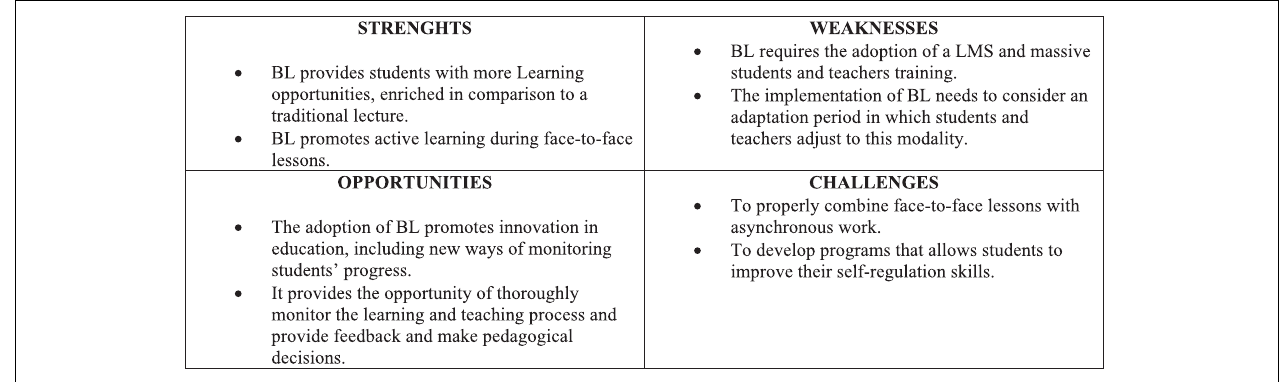
FIGURE 2 | SWOC Analysis of Blended Learning as possible post-pandemic COVID-19 scenario.